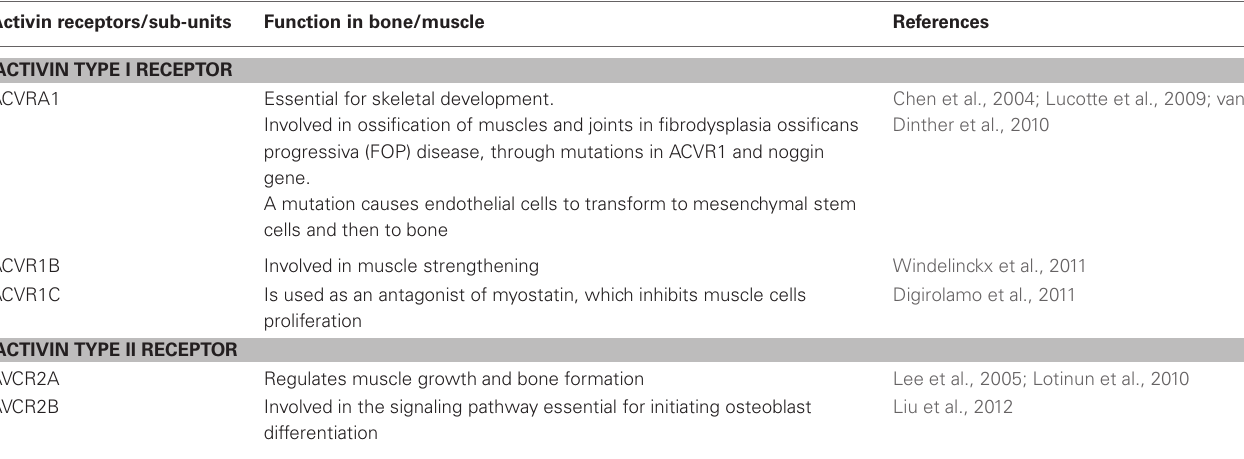
Table 1 | Activin receptor types and their function in the musculoskeletal system. Activin receptors/sub-units Function in